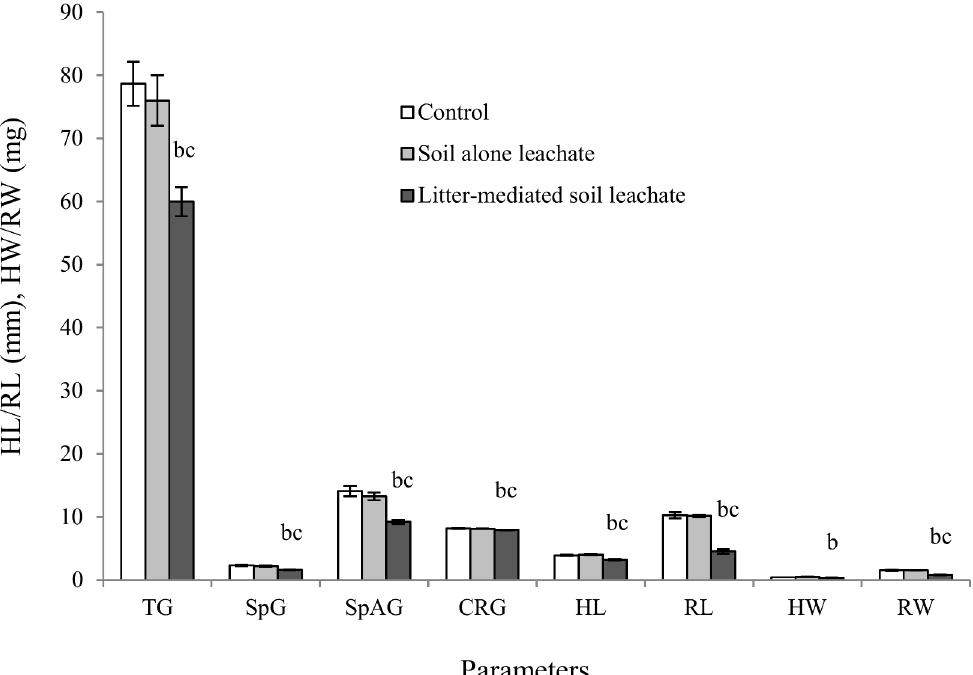
Fig 4. Impact of litter-mediated soil leachate on I . axillaris . The x-axis denotes the types of parameters e.g., total germination (TG), speed of germination (SpG), speed of accumulated germination (SpAG), soefficient of rate of germination (CRG), hypocotyl length (HL), radicle length (RL), hypocotyl weight (HW) and radicle weight (RW). Values on y-axis denote the units of these parameters. Data presented as average while the error bars indicate the standard errors. No filled columns, light ash colour columns and deep ash colour columns represent the impact exhibited by control, soil leachate only and litter-mediated soil leachate respectively. The letter b and c depicts significant decrease of those parameters in I . axillaris exposed to decomposed litter-mediated soil leachate compared with soil alone leachate and control respectively.